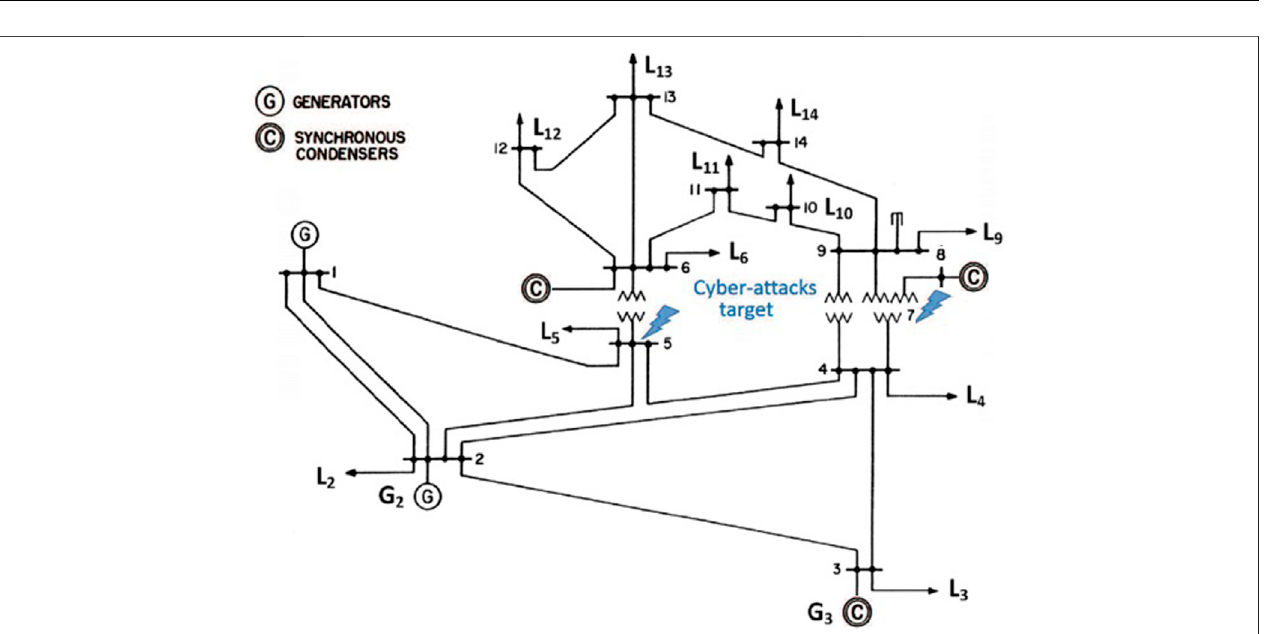
FIGURE 15 | FDI attack on Bus 5,7 on IEEE